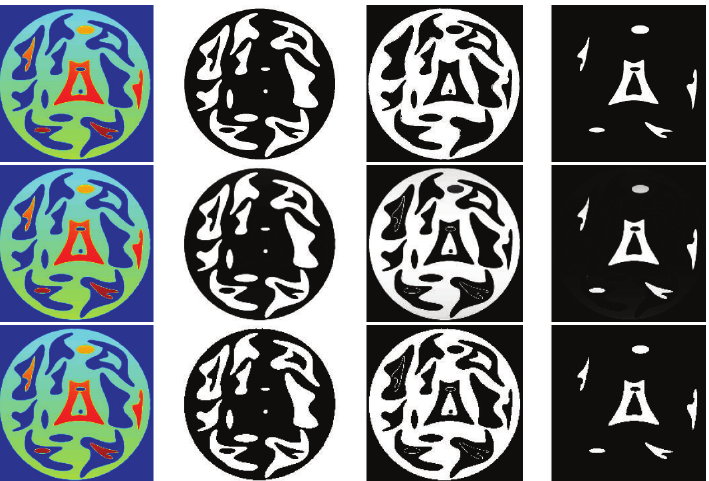
Figure 2: Experiment 3: robustness to bias. In the first line from left to right are original image and three ground truth membership functions. In the second line and the third line, from left to right are original image and soft segmentations (three membership functions). The second row is the soft segmentation using Shen’s model, and the third line is the soft segmentation using the proposed model.